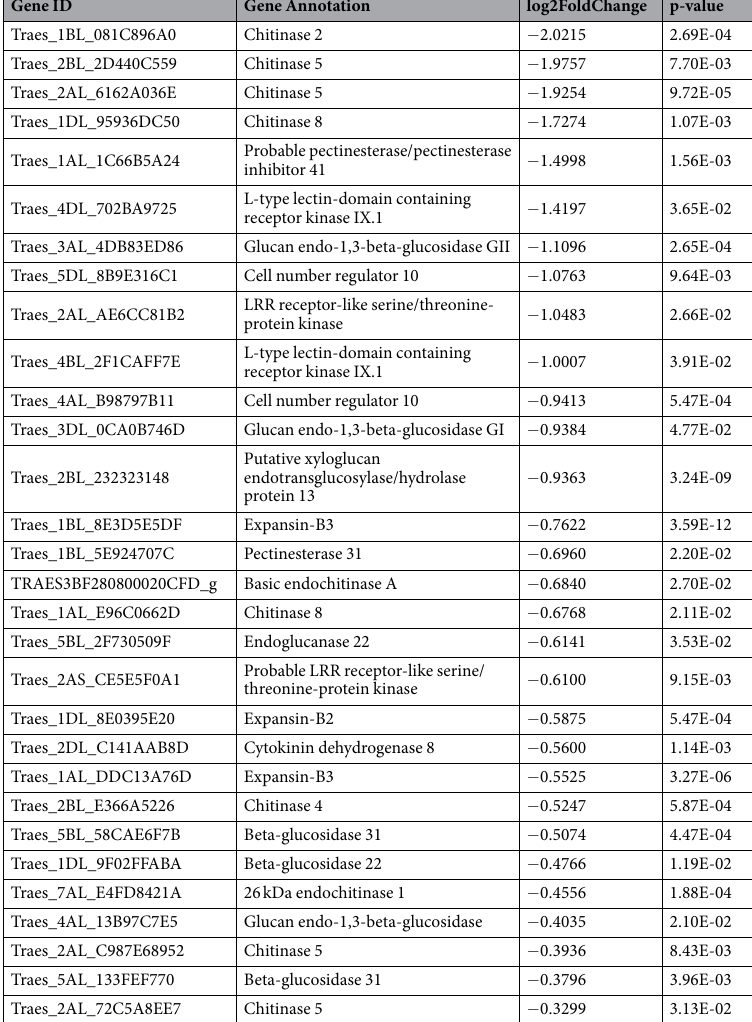
Table 1. List of selected genes about cell wall metabolism that were differentially expressed in B8 VS